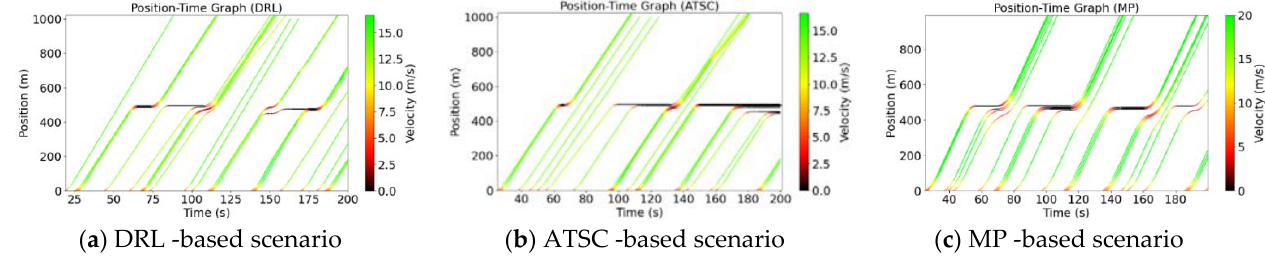
Figure 11. Position–time graph of DRL-, ATSC-, and MP-based scenarios.